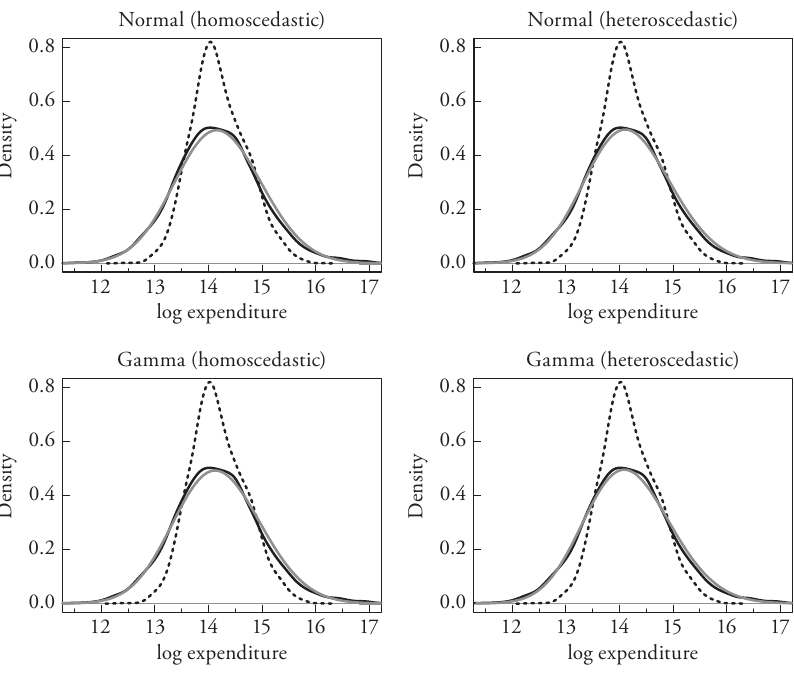
Figure 5: A kernel smooth of the observed log(expenditure) in